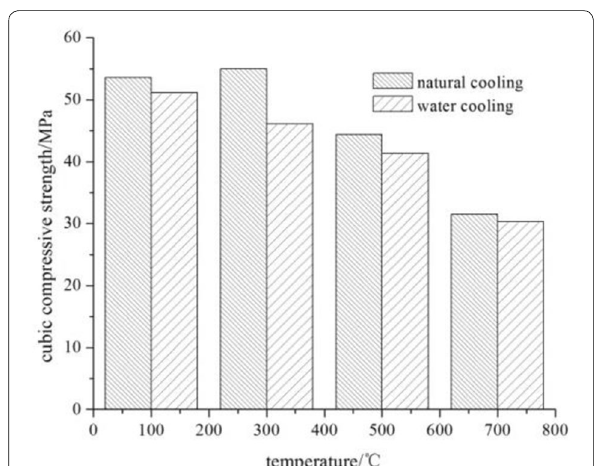
Fig. 7 Relation between cubic compressive strength of T3 and temperature under different